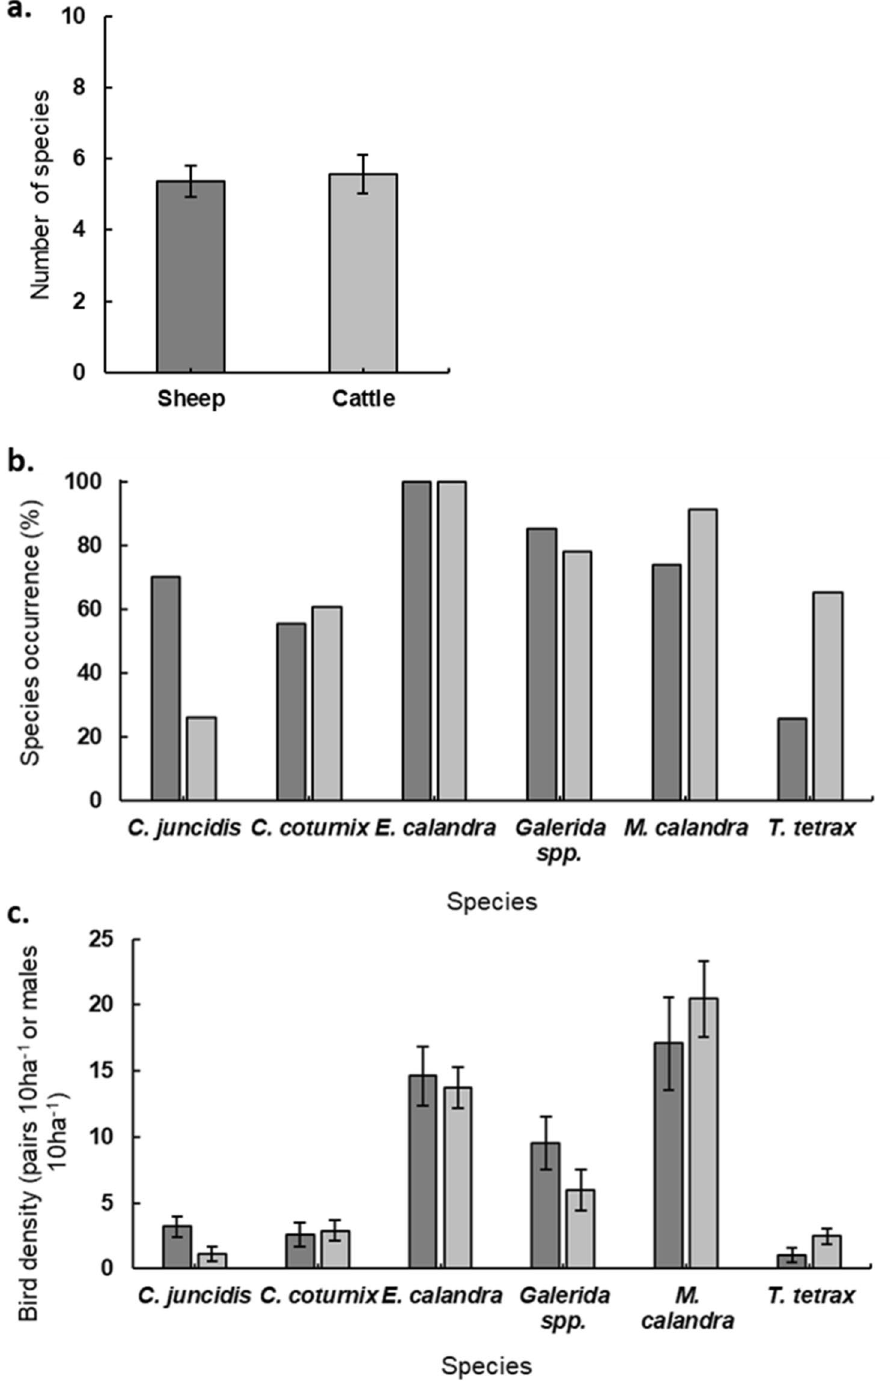
Figure 4. Comparison between sheep (dark grey) and cattle (light grey) grazed parcels for ( a ) Species richness (average number of species in each parcel); ( b ) Occurrence of bird species (% occurrence); ( c ) Average density of bird species (pairs/10 ha or males/10 ha). 95% confidence intervals shown as vertical black lines. *Highlights significant